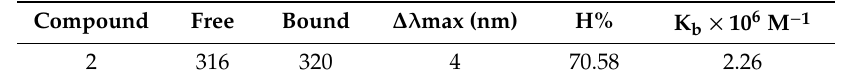
Table 2. Wavelength shifts %, hypochromism (H%), and binding constants of compound 2 using calf thymus